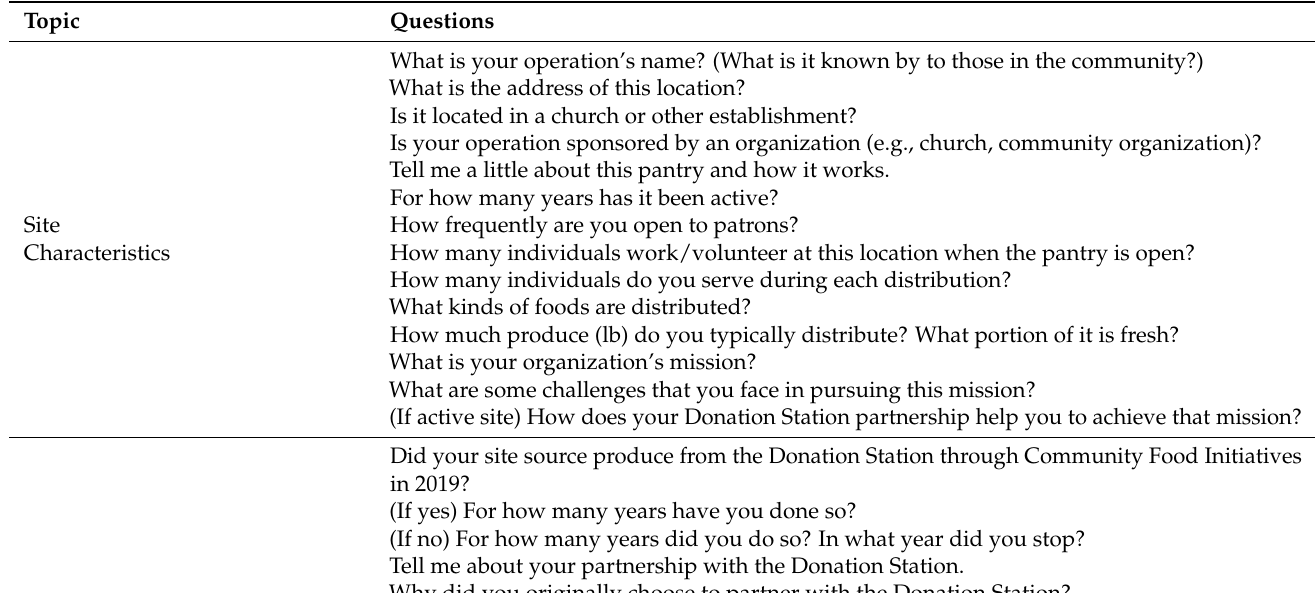
Table A2. Donation Station Site Interview